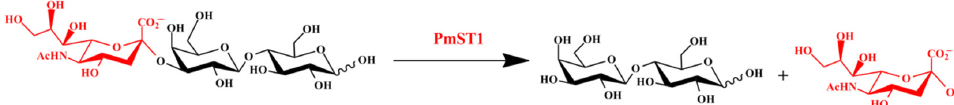
Scheme 1. One-pot two-enzyme synthesis of 3 ′ -sialyllactose (3 ′ -SL). NmCSS: Neisseria meningitidis CMP-sialic acid synthetase; PmST1: Pasteurella multocida α 2,3-sialyltransferase.